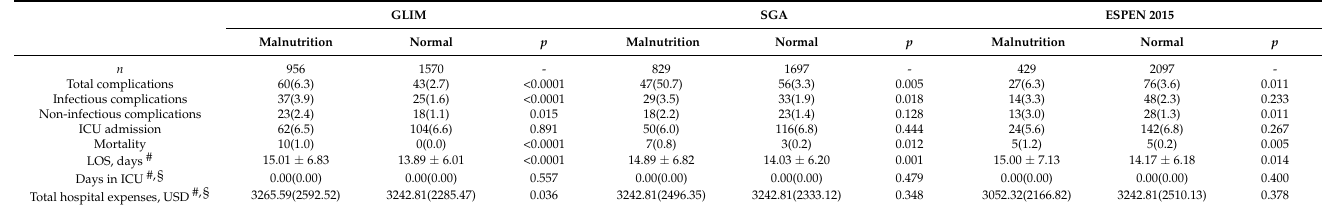
Table 2. Comparison of the adverse clinical outcomes between malnourished and non-malnourished patients diagnosed with the GLIM, SGA, and ESPEN 2015 criteria, respectively.